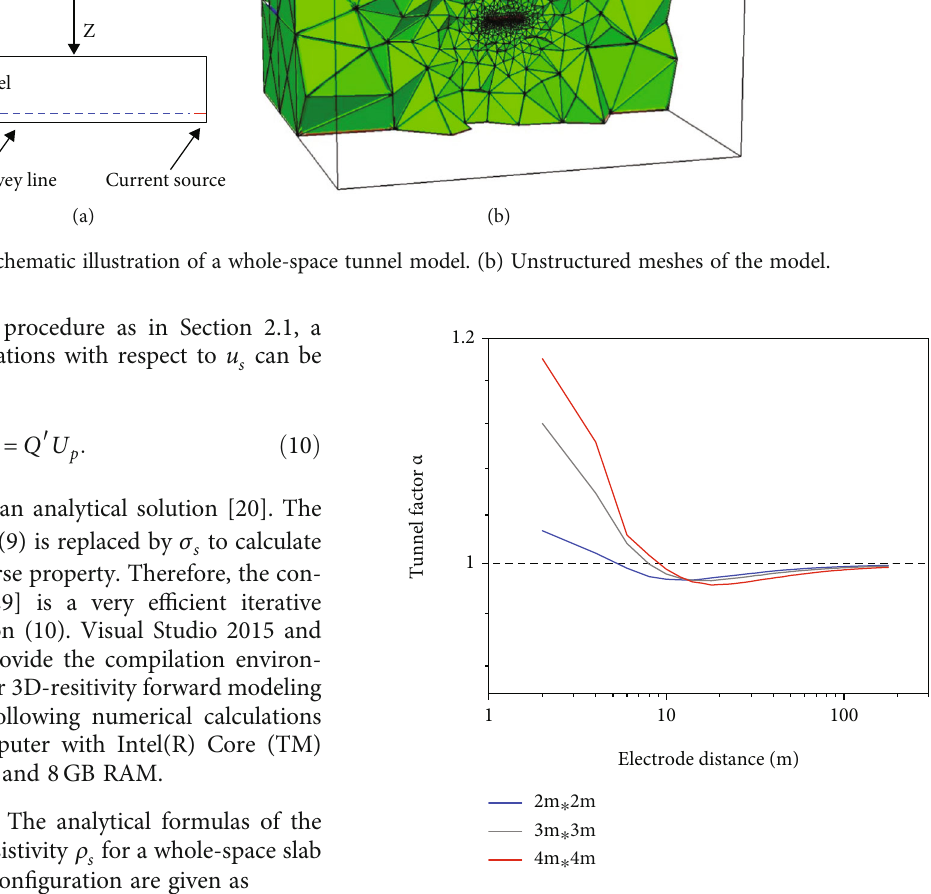
Figure 4: The relationship between the size of tunnel and the tunnel factor.